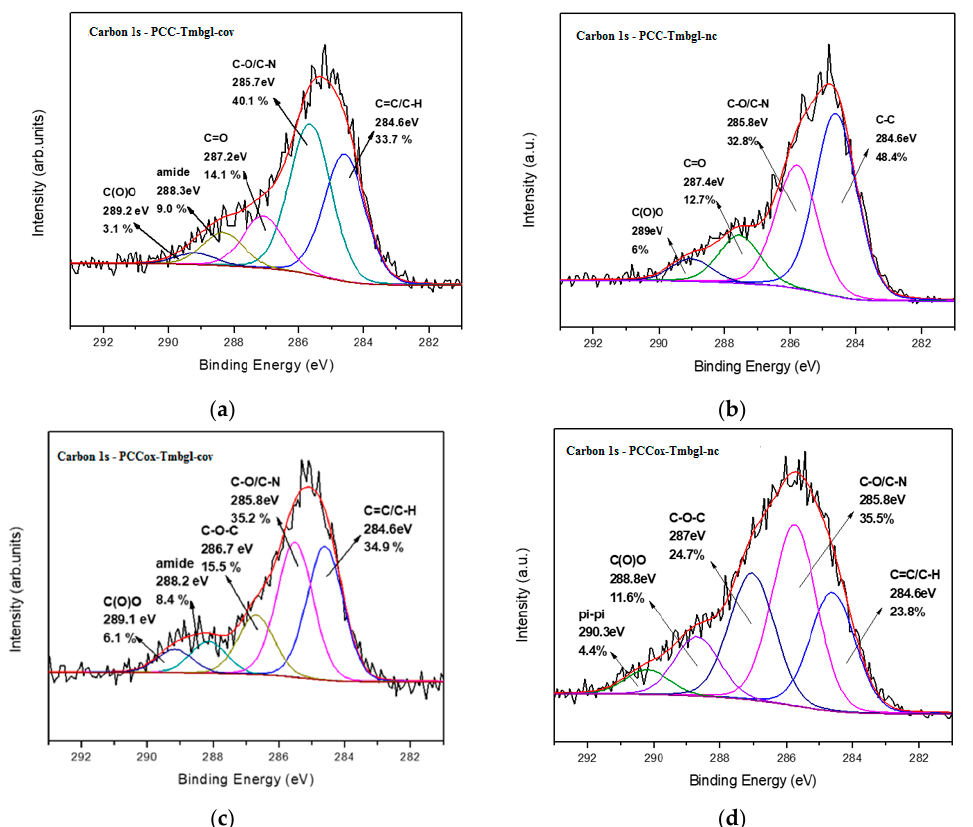
Figure 6. C1s photoelectron spectra of ( a ) PCC-Tmbgl-cov, ( b ) PCC-Tmbgl-nc, ( c ) PCCox-Tmbgl-cov, and ( d ) PCCox-Tmbgl-nc.